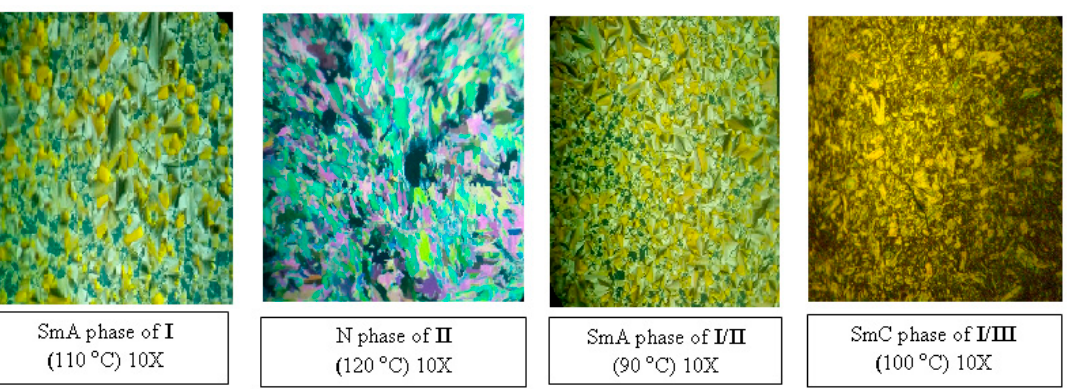
Figure 2. Optical photomicrographs of compounds I and II and their complexes I/II and I/III upon heating. Table 2. Phase transition temperatures ( T , °C) and enthalpy of transition ( ∆ H , kJ/mol) for the individual compounds ( I, II and III ) and their supramolecular complexes ( I/II and I/III).